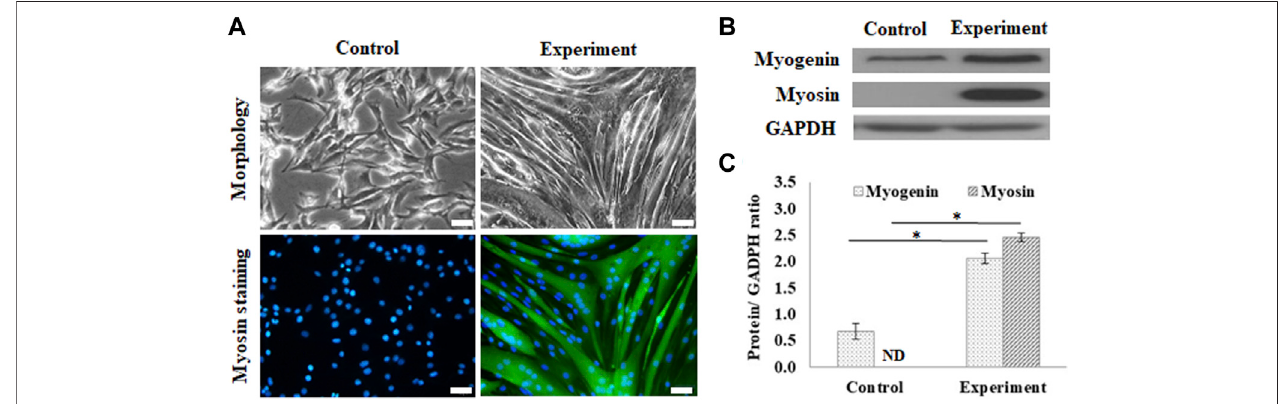
FIGURE 2 | Myogenic differentiation on the GS scaffold without channels. (A) The morphology and myosin immunostaining of the differentiated C2C12 cells after 7 daysofinduction (scalebar =50 μ m). (B) Thewesternblotsofmyogenin,myosin,andGAPDH. (C) Thequanti fi cationofmyogenin andmyosinexpression viatheratio to GAPDH using ImageJ software. The control group comprised cells cultured in the growth medium. Data are presented as the mean ± SD, n = 3, three independent experiments, * p < 0.05, ND is not